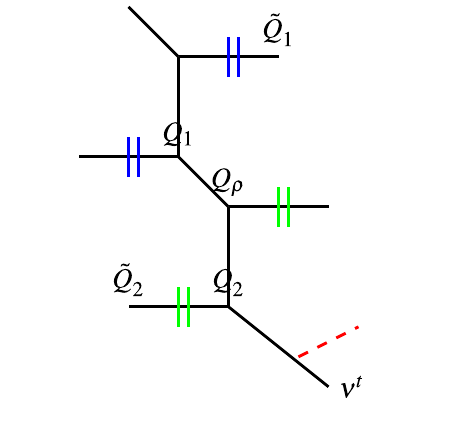
Fig. 7 Geometry after the flop operation in Fig.